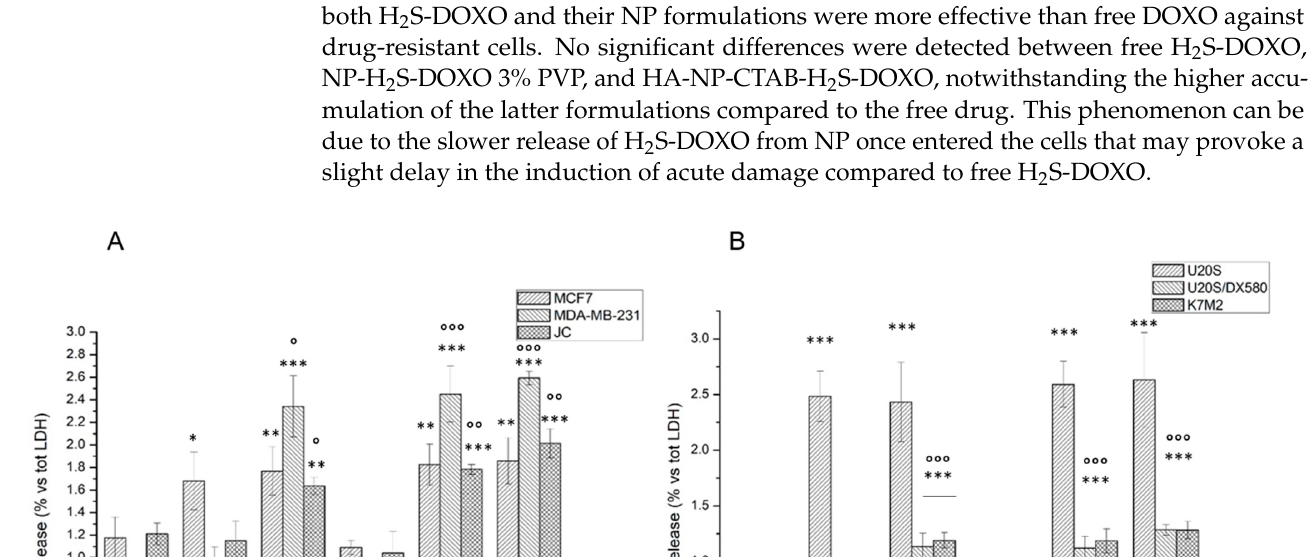
Figure 10. Cell viability: ( A ). breast cancer cells; ( B ). osteosarcoma cells. Cells were incubated 72 h with 5 µM with free DOXO, free H 2 S-DOXO NP-H 2 S-DOXO 3% PVP, and HA-NP-CTAB-H 2 S- DOXO (containing 5 µM H 2 S-DOXO), then the release of LDH was measured by a chemilumines- cence-based assay (n = 4). Data are means + SD. *** p < 0.001: versus ctrl; °°° p < 0.001: versus DOXO; # p < 0.05: versus H 2 S-DOXO.